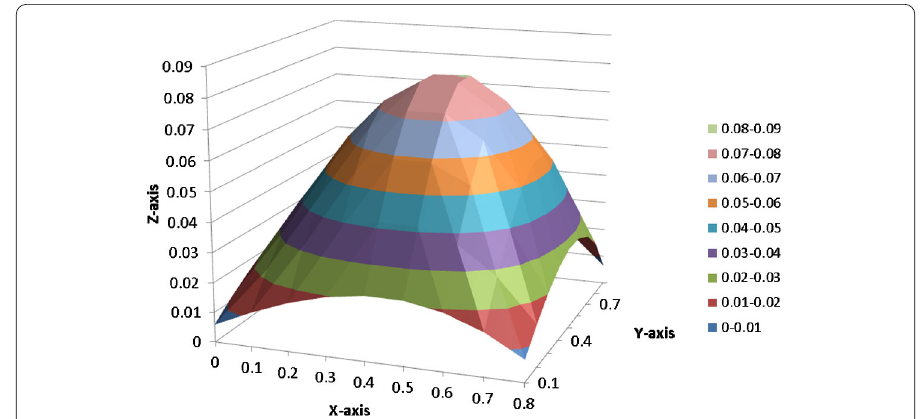
Figure 8 Numerical solution by the FSkG(C-N) method when α = 0.75 of Example 1